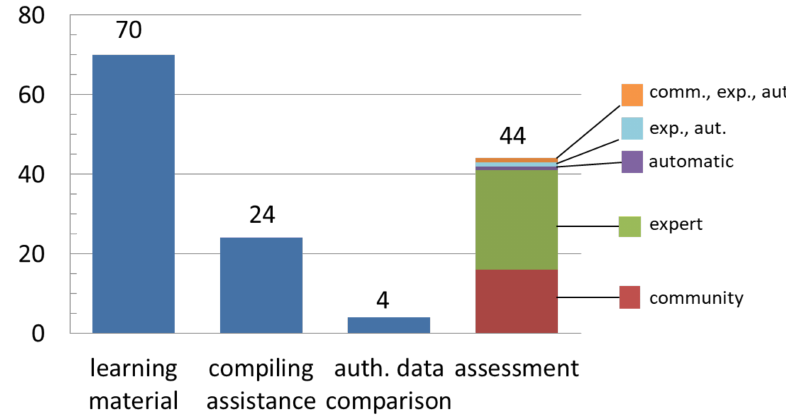
Figure 14. Summary of the results relative to data qualification and validation categories.